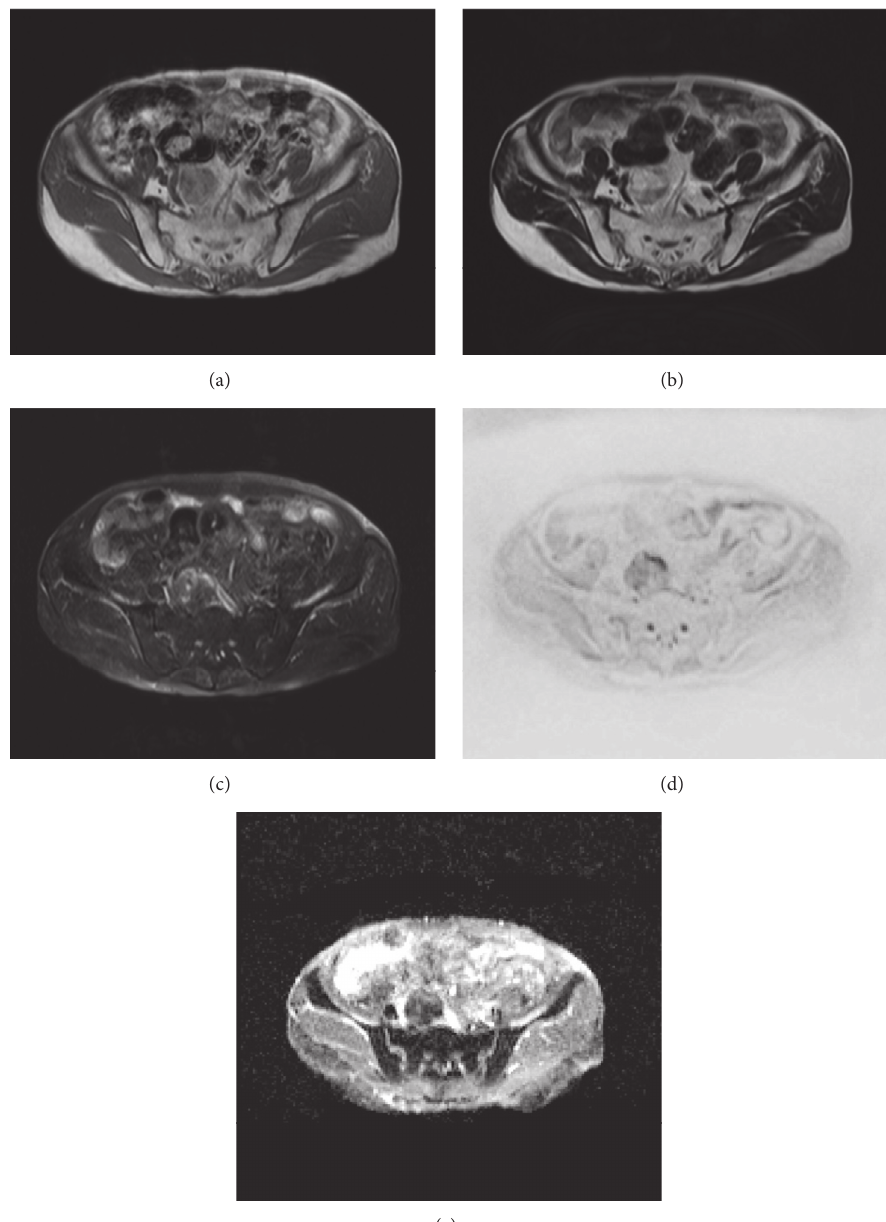
Figure 2: MR images showed a round heterogenous tumor in the presacral space ((a) T1-weighted, (b) T2-weighted, (c) fatty-saturated T2- weighted, and (d) diffusion-weighted image ( 𝑏 = 800 ) and (e) ADC